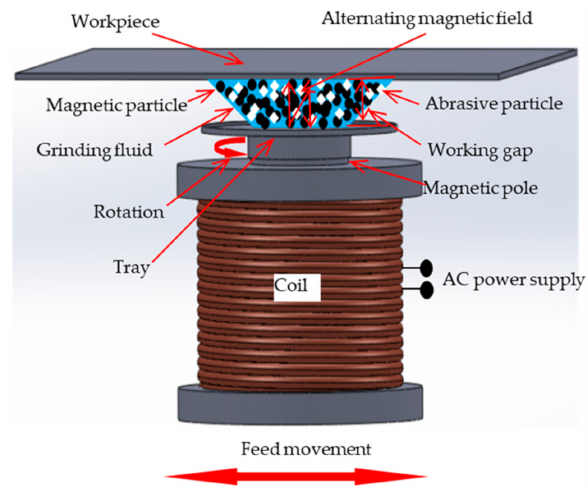
Figure 1. Schematic of processing principle.